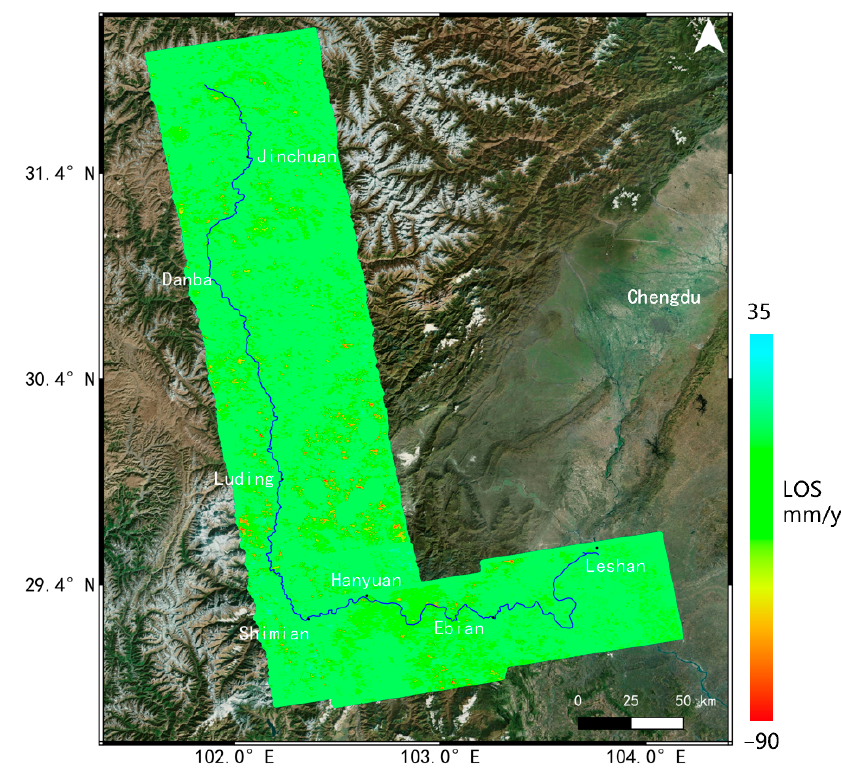
Figure 9. The deformation rate map for the Dadu River Basin from − 2017 to 2022. The blue line is the Dadu River.